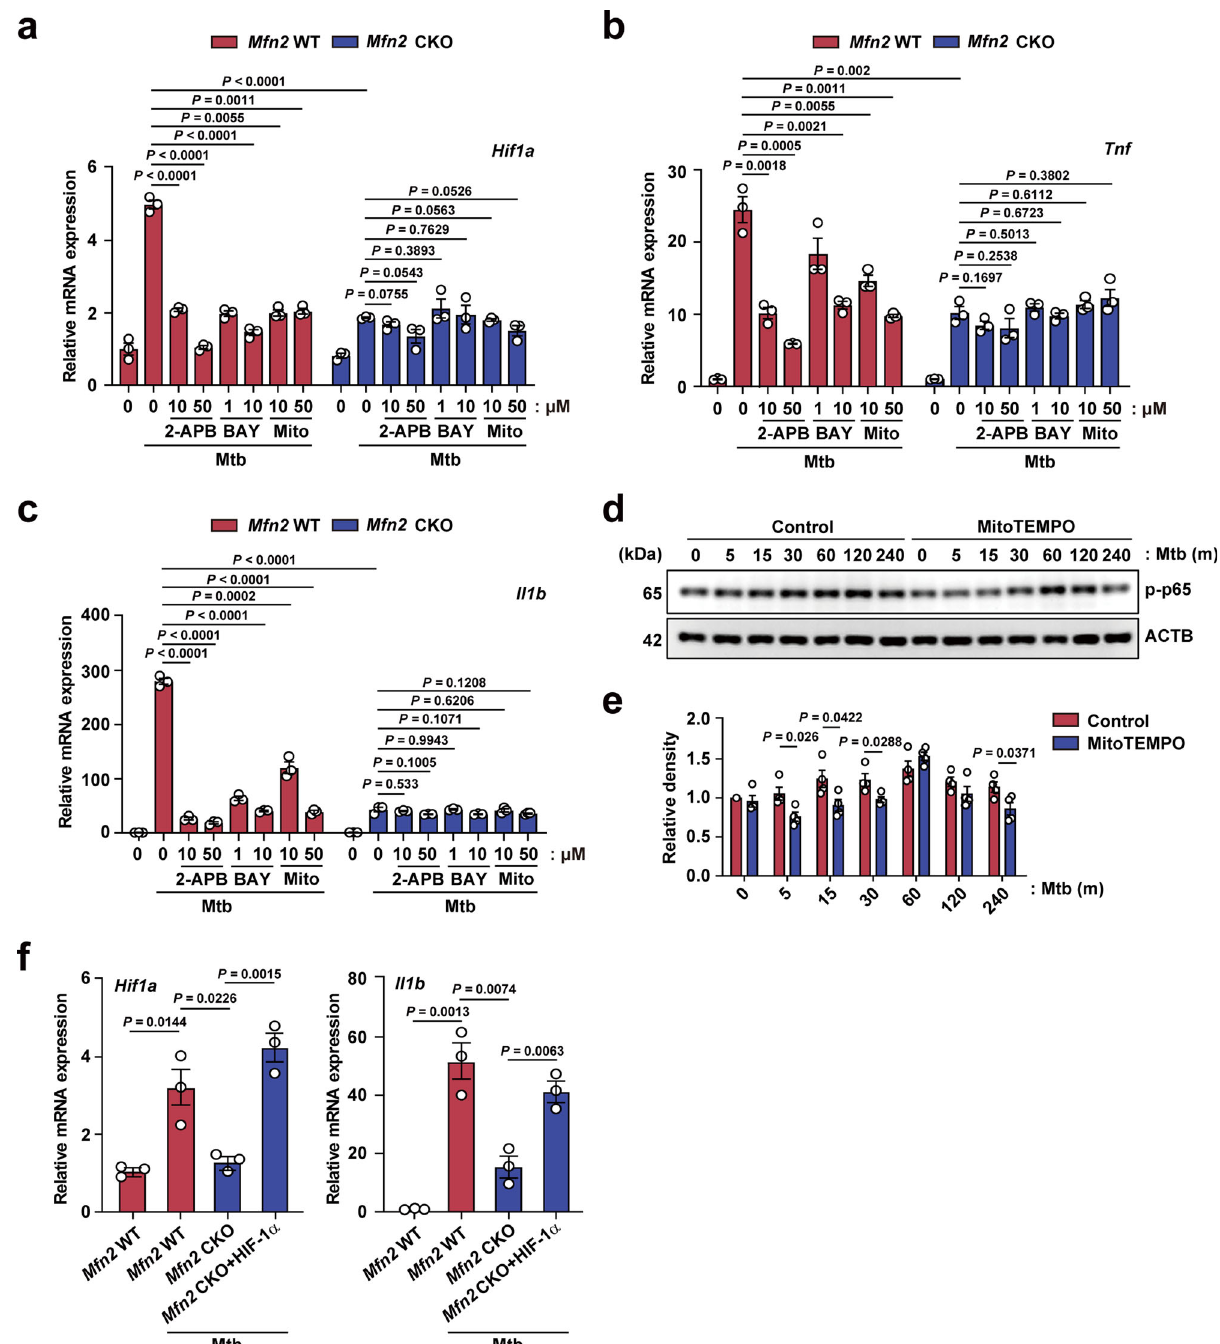
Fig. 5 MFN2-mediated mtROS production control the HIF-1 α expression and in fl ammatory signaling. a – c BMDMs from Mfn2 WT or Mfn2 CKO mice were infected with Mtb (MOI 5) and treated with indicated doses of 2-APB, BAY 87-2243 (BAY) or MitoTEMPO (Mito) for 18 h. qPCR was performed to detect the mRNA expression of Hif1a ( a ) , Tnf ( b ), and Il1b ( c ). d Western blot analysis of phosphorylation of p65 in Mfn2 WT BMDMs treated with MitoTEMPO (100 μ M) for 1 h and infected with Mtb (MOI 5) for indicated time. e Relative density is shown in graph ( n = 4). f qPCR analysis of indicated genes in Mfn2 WT or Mfn2 CKO BMDMs transduced with lentivirus expressing HIF-1 α for the overexpression and infected with Mtb (MOI 5) for 18 h ( n = 3). Representative data of two to three independent experiments are shown. Two-tailed Student ’ s t test is used to calculate the signi fi cance ( a – c , e , f ). BAY, BAY 87-2243; Mito,